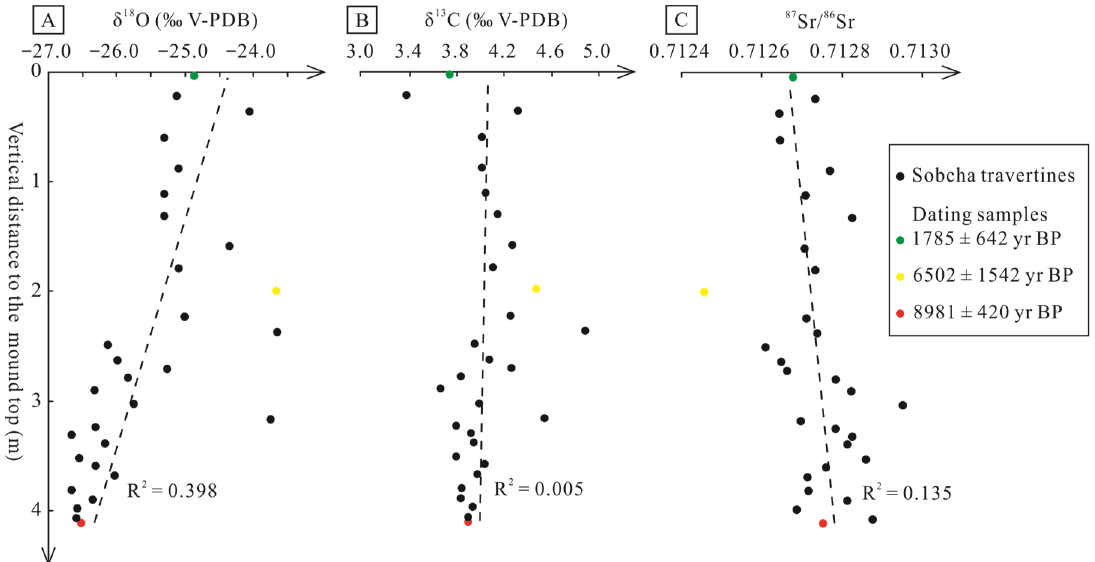
Figure 5. ( A – C ) Vertical variations of δ 18 O, δ 13 C, and 87 Sr/ 86 Sr of the Sobcha travertines in the studied profile.